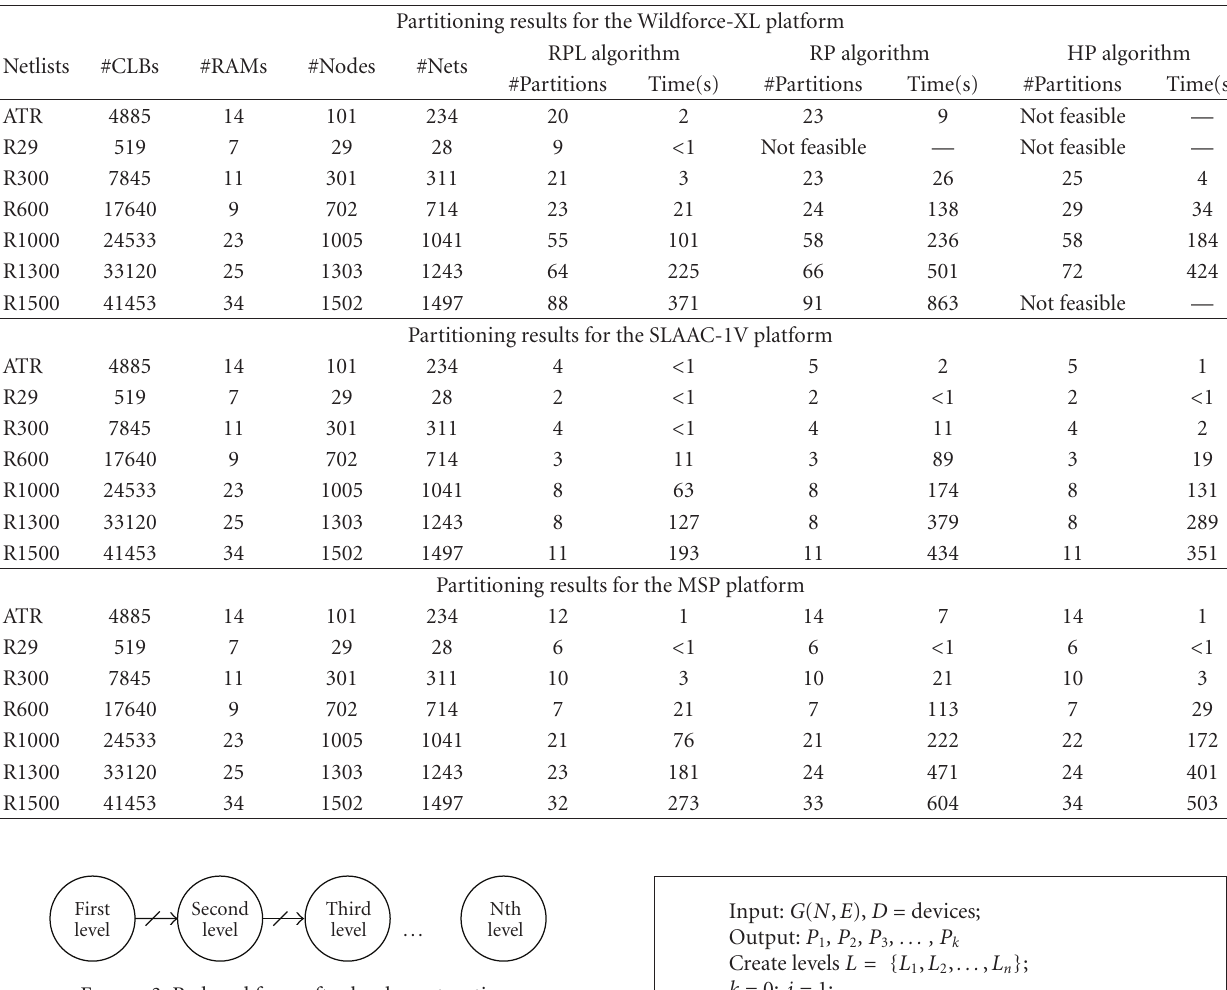
Table 1: Partitioning results for the Wildforce-XL, the SLAAC, the MSP boards. Partitioning results for the Wildforce-XL platform